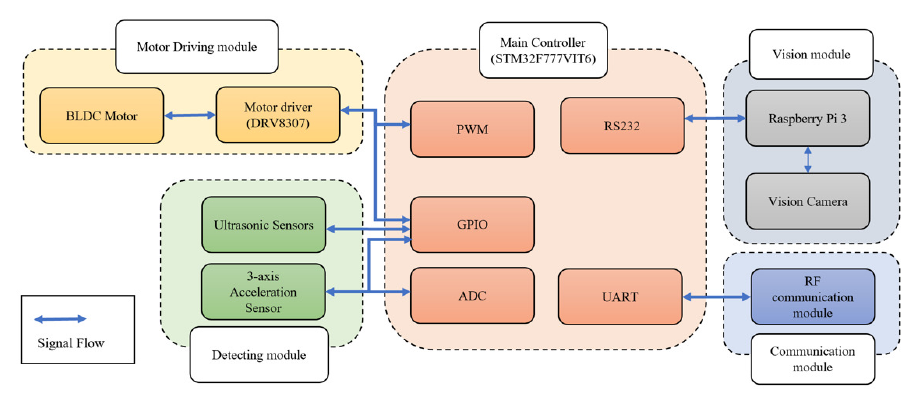
Figure 5. System architecture of the onboard robotic platform.